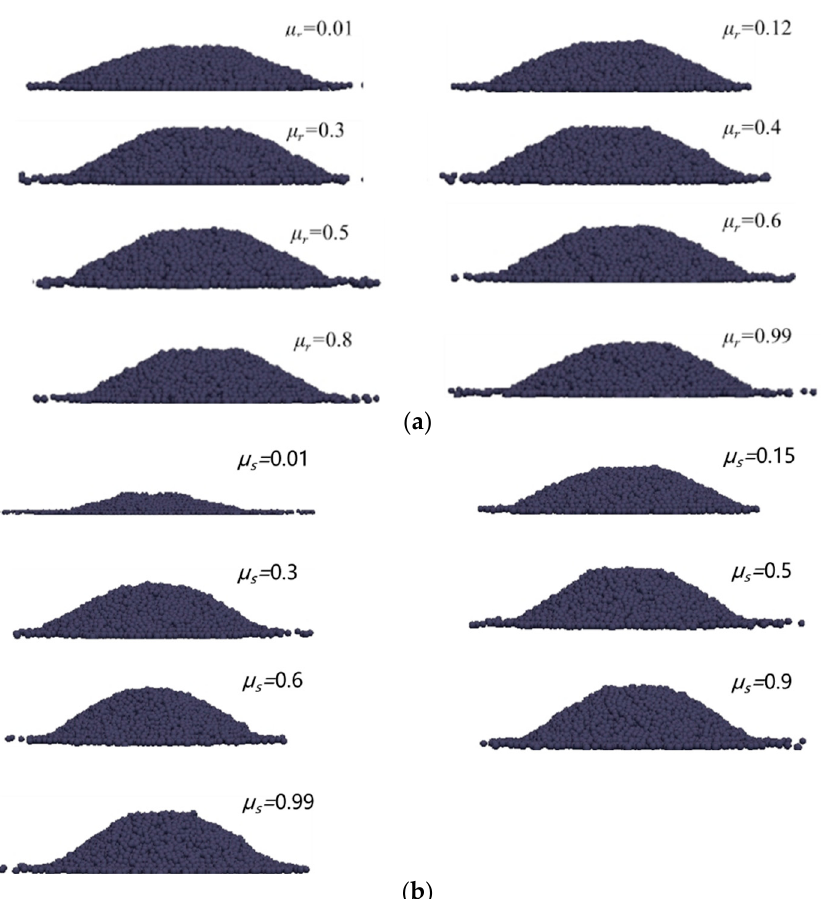
Figure 3. Vertical cross-sections of the pellet pile simulated under different ( a ) rolling and ( b ) static friction ( b ) coefficients.